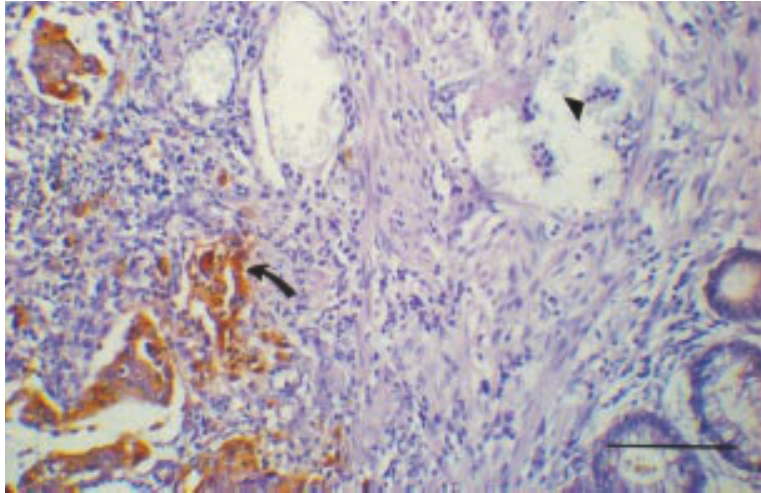
Figure 1 - Immunoperoxidase staining of a colorectal carcinoma tissue section with mAb 6D1.1. Tumor tissue presents positive staining (arrow), whereas neutrophils do not (arrow- head). Bar corresponds to 100 µm. Magnification, 400